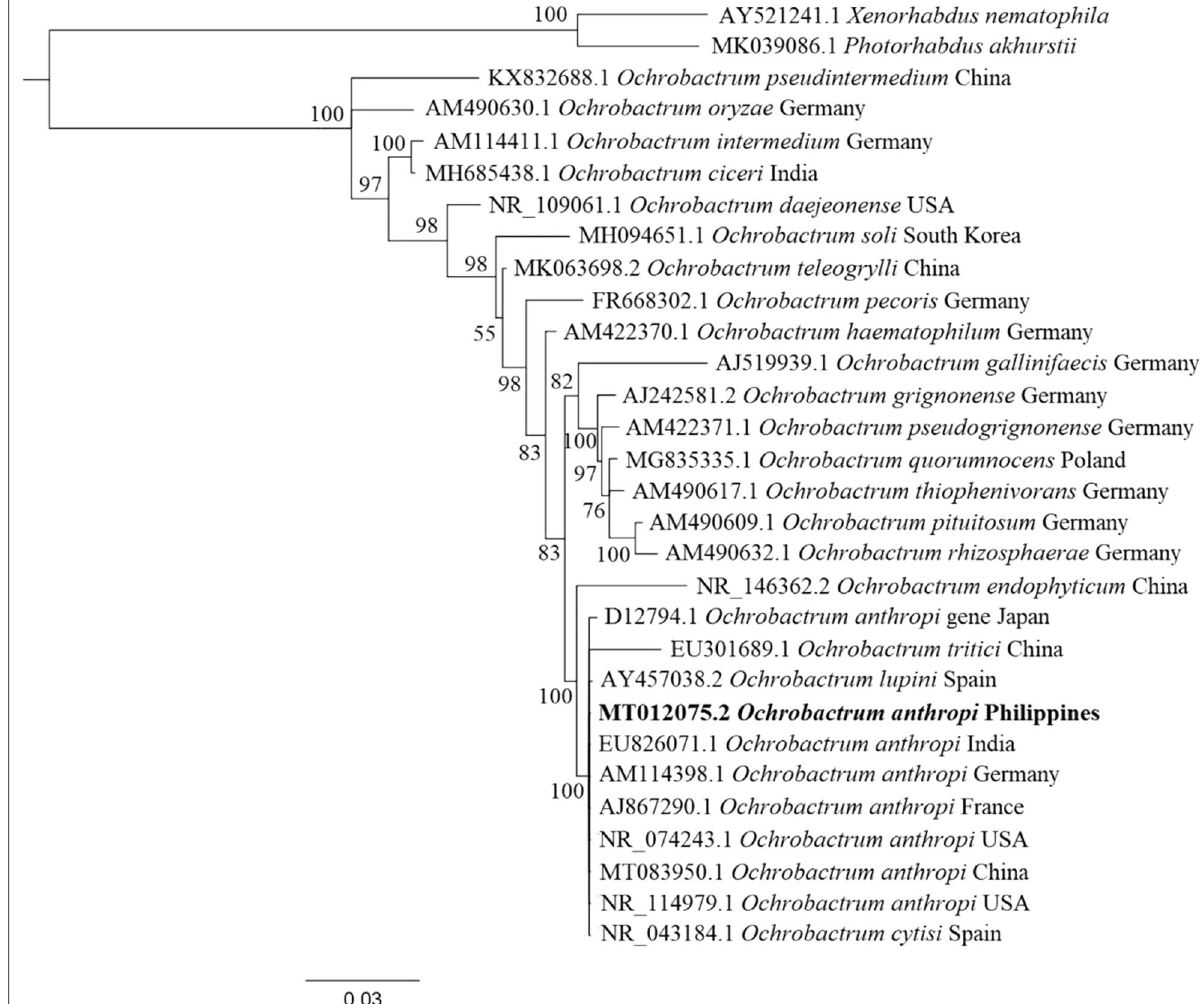
Fig. 2 Phylogenetic relationships of Ochrobactrum anthropi and other Ochrobactrum species as inferred from Bayesian analysis of sequences of the 16S rDNA region. Bayesian posterior probabilities (%) equal to or more than 60% are given for appropriate clades. The scale bar shows the number of substitutions per